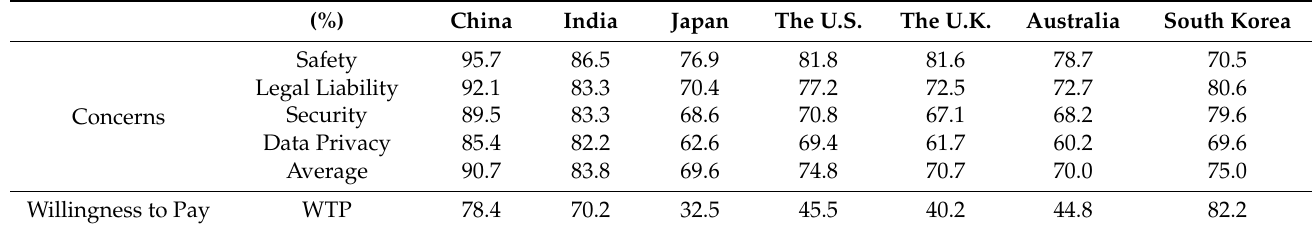
Table 2. Results in the literature and our